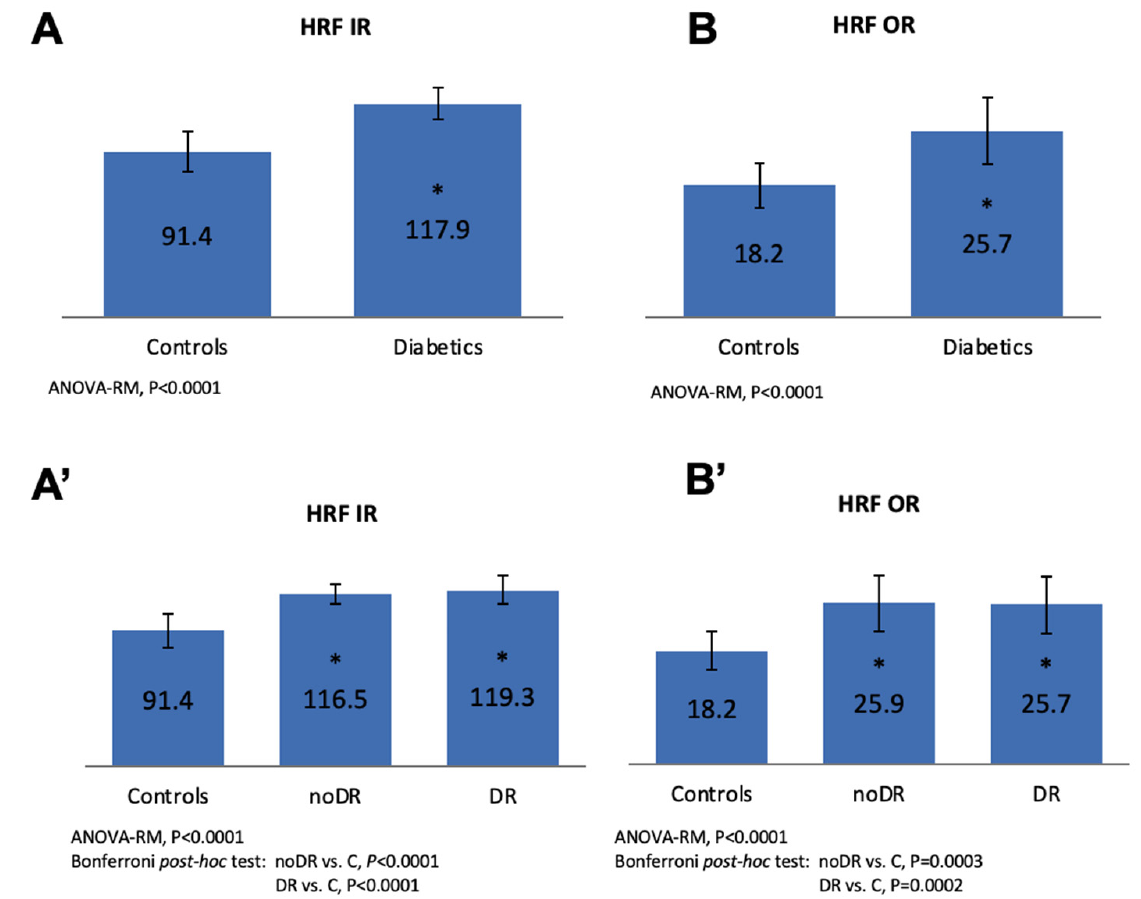
Figure 3. Representation of mean number of hyperreflective intraretinal foci (HRF) in the inner (IR) and outer retina (OR) in all diabetic eyes versus healthy controls ( A , B ) and in diabetic eyes without DR (noDr) and with mild DR (DR) versus controls ( A’ , B’ ). A significantly increased number of HRF in the IR and OR of all diabetics versus controls and in each diabetic group versus controls was found. * Statistically significant di ff erence compared to